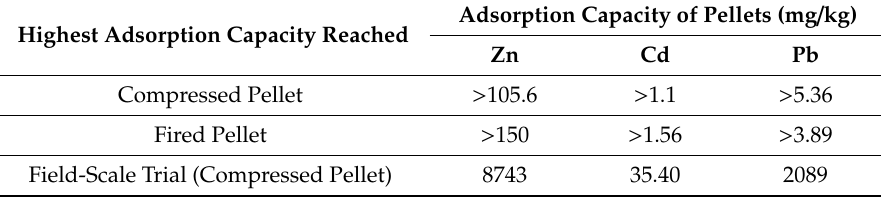
Table 3. Highest adsorption capacities achieved from the column experiment for the CP and FP [19].